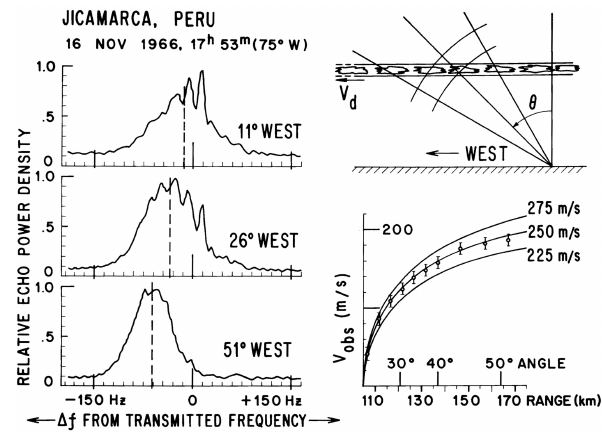
Fig. 9. Simultaneous type 2 echo Doppler spectra at 50MHz at different zenith angles. The dashed lines show the means, which fit a sine dependence on the zenith angle for a 250m/s velocity (from Balsley, 1969).